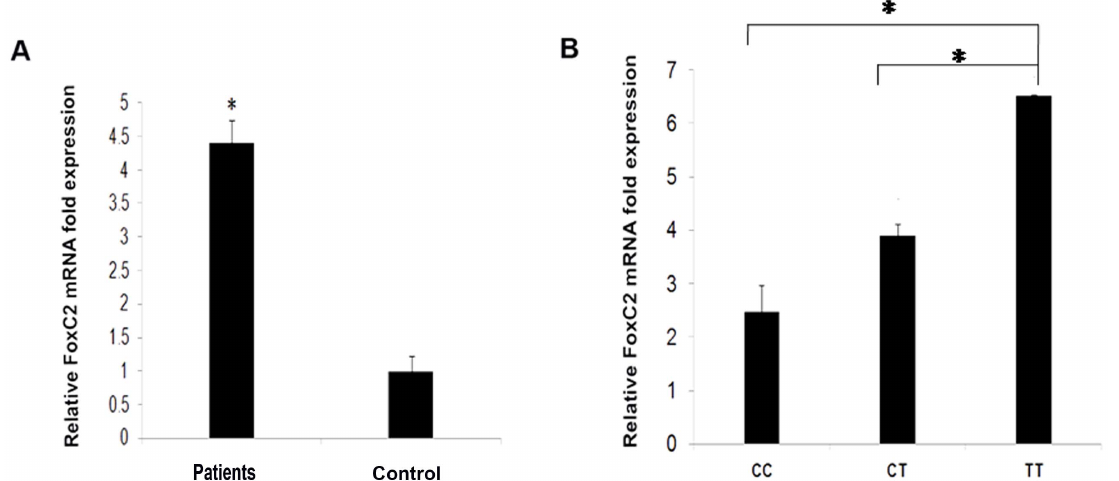
Figure 1. FoxC2 mRNA expression in saphenous vein tissues from patients with CVD and healthy subjects. (A) Relative Foxc2 mRNA fold increase in CVD tissues (n=22) compared to control specimens (n=20). (B) Relative FoxC2 mRNA levels in vein tissues from patients carrying CC, CT and TT genotypes of c.-512C . T (rs34221221) variant. The difference in expression in patients with CT and TT genotypes were statistically significant compared to wild CC genotype (*p , 0.05). Data shown are the mean 6